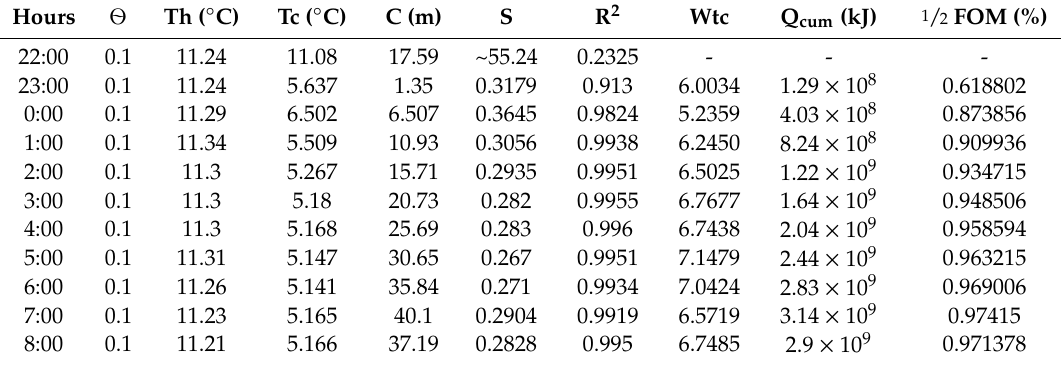
Table A8. 13th–14th October 2019 Curve Fitting and Performance Parameter analysis.